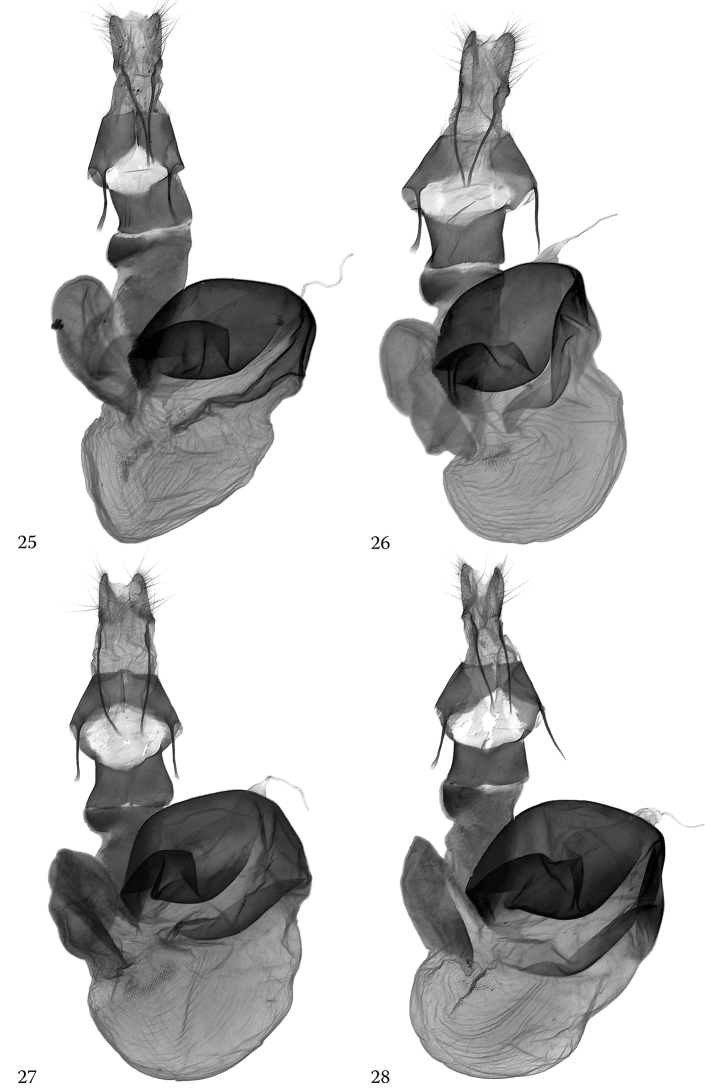
Hoplodrina spp., female genitalia. 25Hoplodrina
alsinides (Costantini, 1922), Paratype, Italy, slide No.: OP1414 26Hoplodrina
alsinides (Costantini, 1922), Austria, East Tyrol, slide No.: OP1416 27Hoplodrina
octogenaria (Goeze, 1781), Austria, North Tyrol, slide No.: OP1409 28Hoplodrina
octogenaria (Goeze, 1781), North Macedonia, slide No.: OP1410.